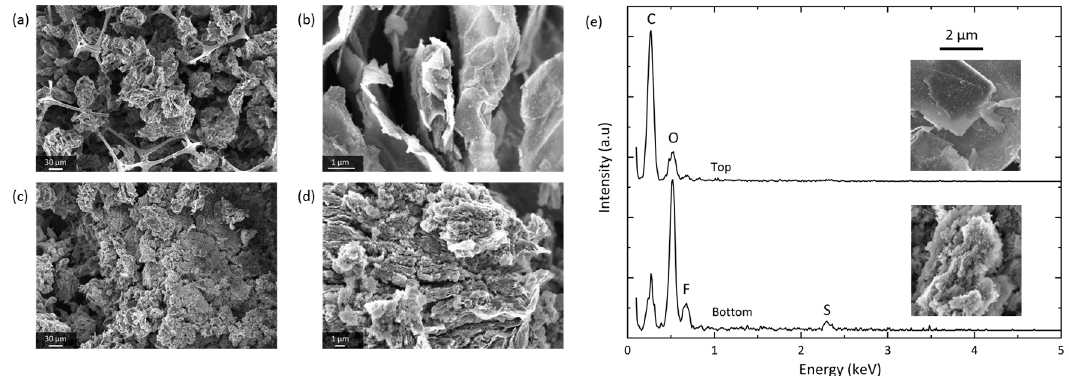
Figure 5. SEM images of a GNS-foam electrode after discharge to 17.8 mAh/cm 2 at 150 µA/cm 2 with 200 µL of 1.0 M LiTFSI-TEGDME. ( a ) Overview image of electrode top. ( b ) Intact, but only thin film-coated GNS at the electrode top. ( c ) Expansion of a GNS bundle at the electrode bottom. ( d ) Heavily deteriorated GNS at the electrode bottom. ( e ) EDS spot spectra of GNS at electrode top and bottom with corresponding SEM images.